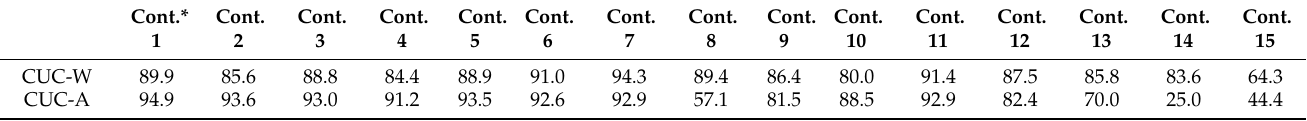
Table 4. Christiansen Uniformity Coefficient results over time.